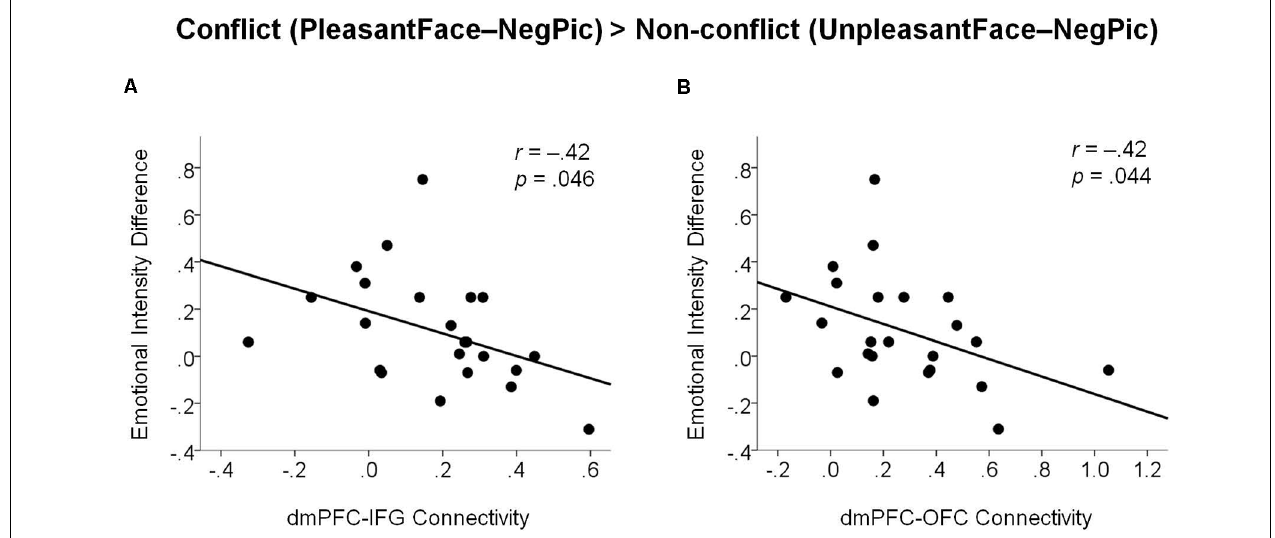
FIGURE 5 | Scatter plots illustrating negative associations between changes in emotional intensity ratings by emotional incongruency and dmPFC functional connectivity with the right IFG (A) and with the right OFC (B) . dmPFC, dorsomedial prefrontal cortex; IFG, inferior frontal gyrus; OFC, orbitofrontal